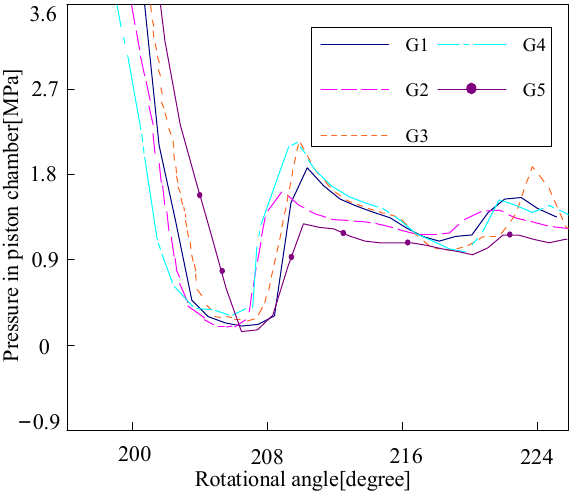
Figure 14. Pressure in the piston chamber with different slot geometries at the beginning of the suction phase.